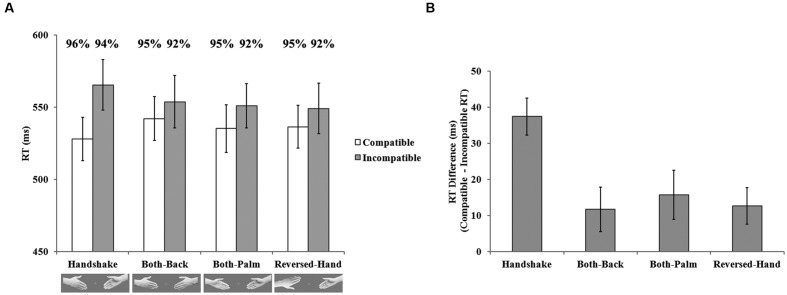
Results of Experiment 2. (A) Mean RT varied as a function of hand-approaching display and compatibility. Mean accuracy rates for every condition was shown above the corresponding bars. (B) The mean RT difference between compatible and incompatible trials according to the hand-approaching display is shown. Error bars indicate standard errors.